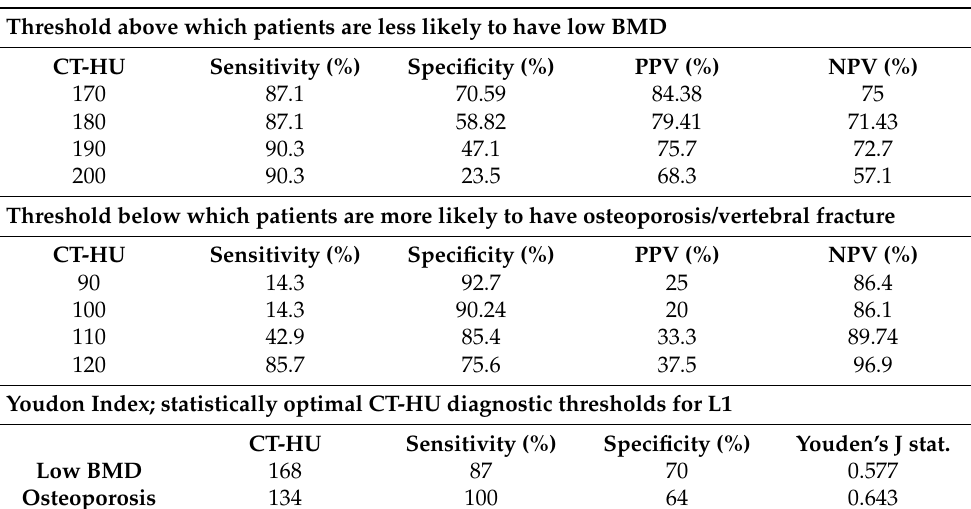
Table 4. Clinically useful thresholds for identifying low BMD and osteoporosis, with Youdon’s J-statistic thresholds for